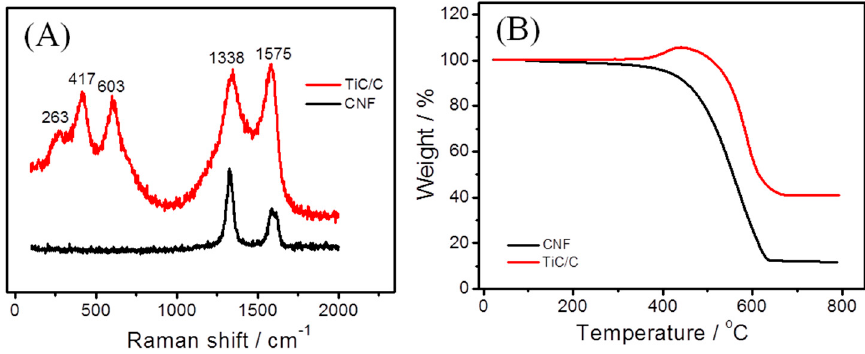
Figure 2. Raman spectra ( A ) and TGA curves ( B ) of TiC/C and CNF in air atmosphere.